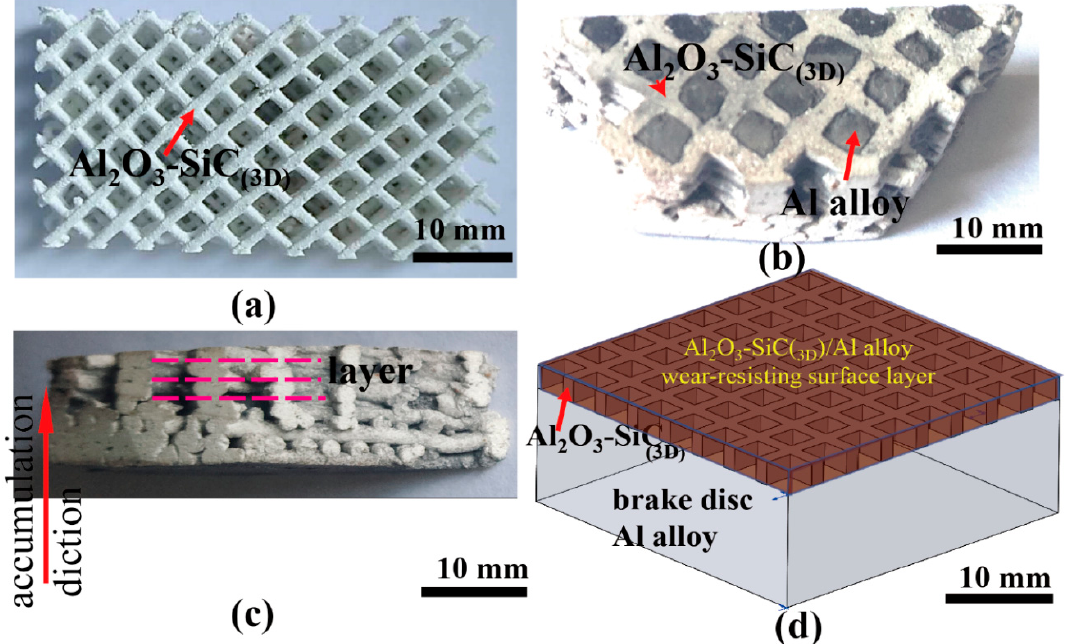
Figure 17. Macrostructures of Al 2 O 3 -SiC reticulated porosity ceramics (RPCs) and Al 2 O 3 -SiC (3D) /Al alloy: ( a ) sintered Al 2 O 3 -SiC RPCs; ( b ) fracture morphology of Al 2 O 3 -SiC (3D) /Al alloy; ( c ) side view of Al 2 O 3 -SiC (3D) RPCs; ( d ) diagrammatic sketch of brake disc with layer.